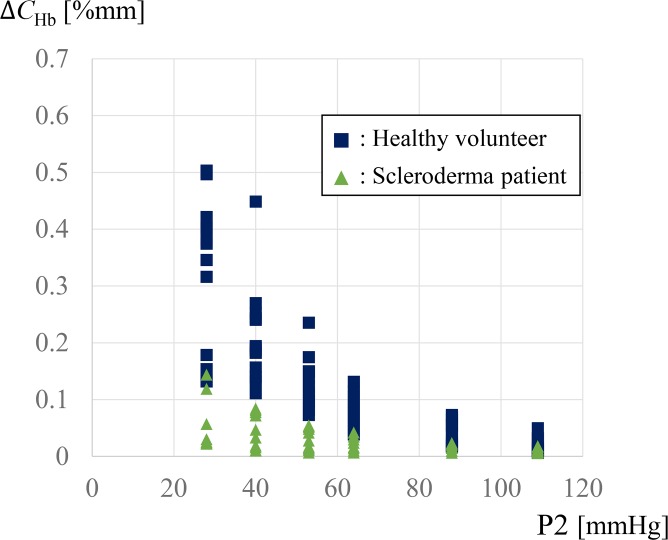
ΔCHb measured in four healthy volunteers and four scleroderma patients.